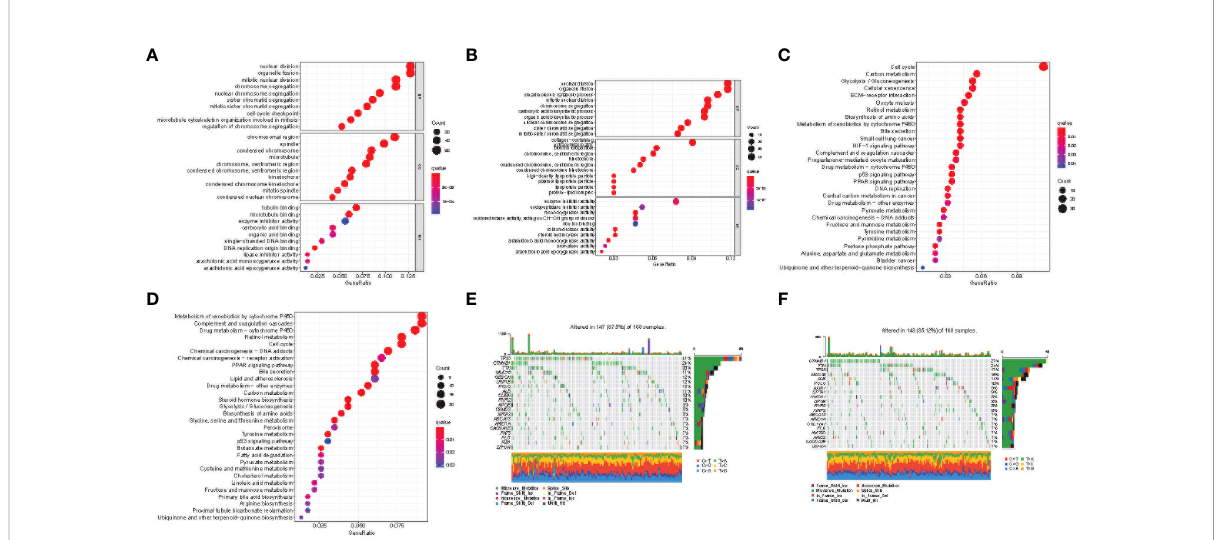
FIGURE 7 Functional enrichment of the cuproptosis and TCA-related genes between risk groups. Results of GO enrichment analyses in the TCGA (A) and ICGC (B) cohorts. Results of KEGG enrichment analyses in the TCGA (C) and ICGC (D) cohorts. The 20 genes with the highest mutation frequency in the high-risk (E) and low-risk (F) groups of the TCGA